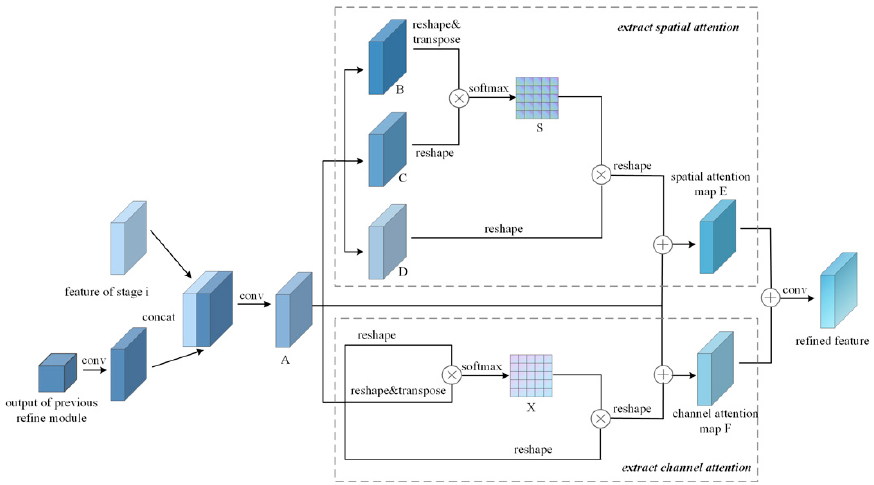
Figure 4. Structure of the refine module.